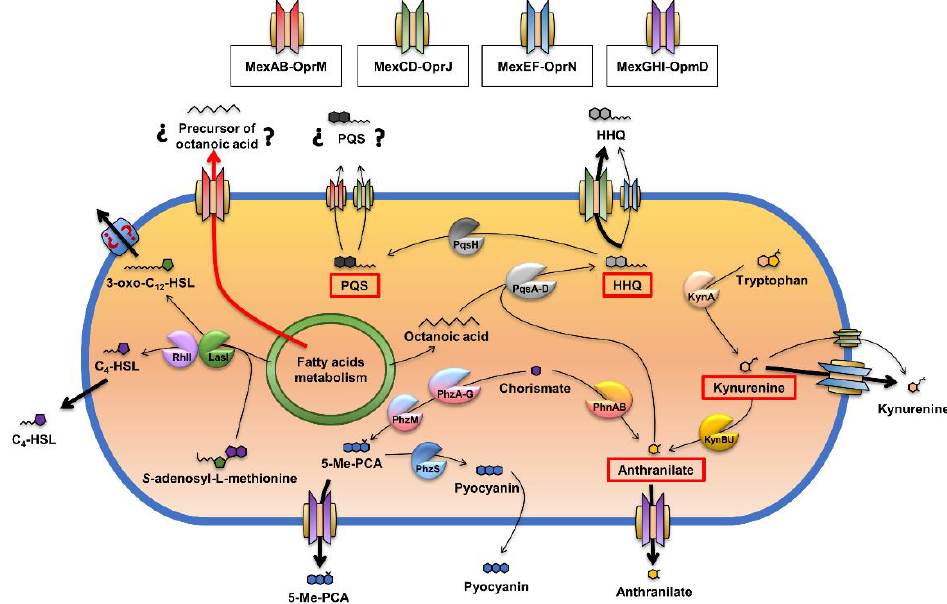
Figure 1. Schematic representation of the synthesis of QSSMs and their relationship with RND efflux activity in P. aeruginosa . Previous studies have shown that MexAB-OprM, MexCD-OprJ, and MexEF-OprN are efflux system able to extrude QS-related compounds, a feature that produces an impaired QS response and virulence factors production. Therefore, the overexpression of MexAB-OprM has been associated with an impaired production (not extrusion) of one of the immediate precursors of HHQ, octanoic acid, rather than with a nonphysiological extrusion of 3-oxo-C12-HSL as was initially stated [24,48]. In our work, we suggested that this lower availability of octanoic acid is probably due to the efflux of some of the intermediates in fatty acid metabolism that function as precursors of octanoate synthesis. With respect to MexCD-OprJ and MexEF-OprN, both of them are able to efflux HHQ and the AQs precursor kynurenine [23,25,49], but with different efficiency, being the extrusion of either HHQ or kynurenine most relevant in mutants that overexpress MexCD-OprJ or MexEF-OprN, respectively. Some other studies have also associated the activity of the MexGHI- OpmD efflux system with the QS network at two different levels: (i) extruding anthranilate, which is the other one immediate precursor of HHQ [26], and (ii) extruding 5-Me-PCA, the immediate precursor of pyocyanin, a QS-controlled virulence factor that in turns drives the expression of some other QS-related genes [50]. Altogether, these results support that RND efflux systems are a key element in the modulation of the QS response at different levels